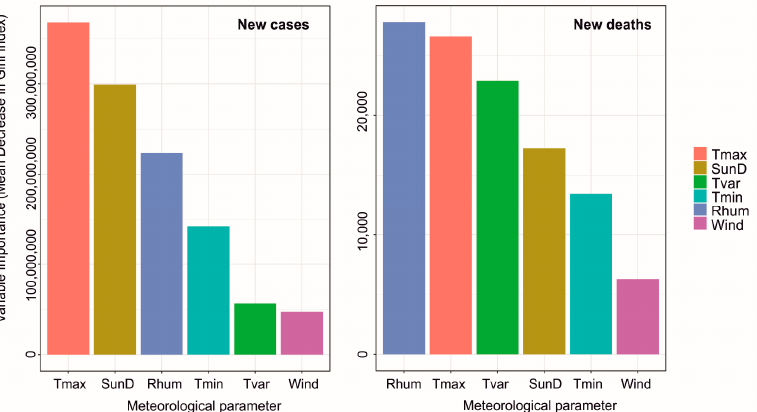
Figure 7. Variables importance from random forest fit. Maximum temperature—Tmax, minimum temperature—Tmin, variability of mean daily temperature—Tvar, sunshine duration—SunD, wind speed—Wind, relative humidity—Rhum.